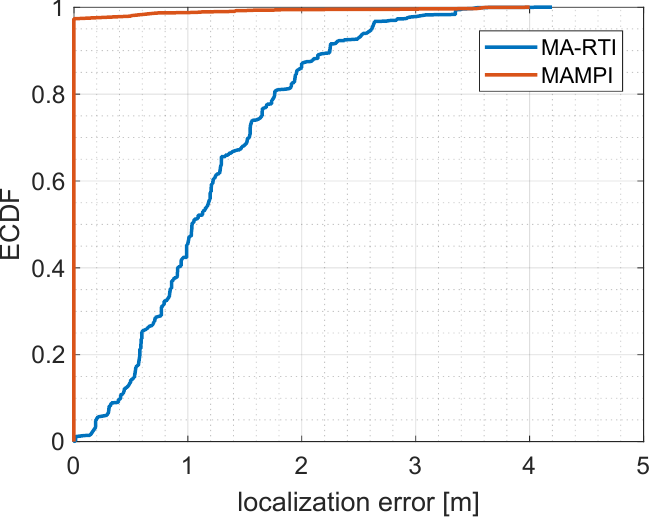
Figure 15. Photograph of the